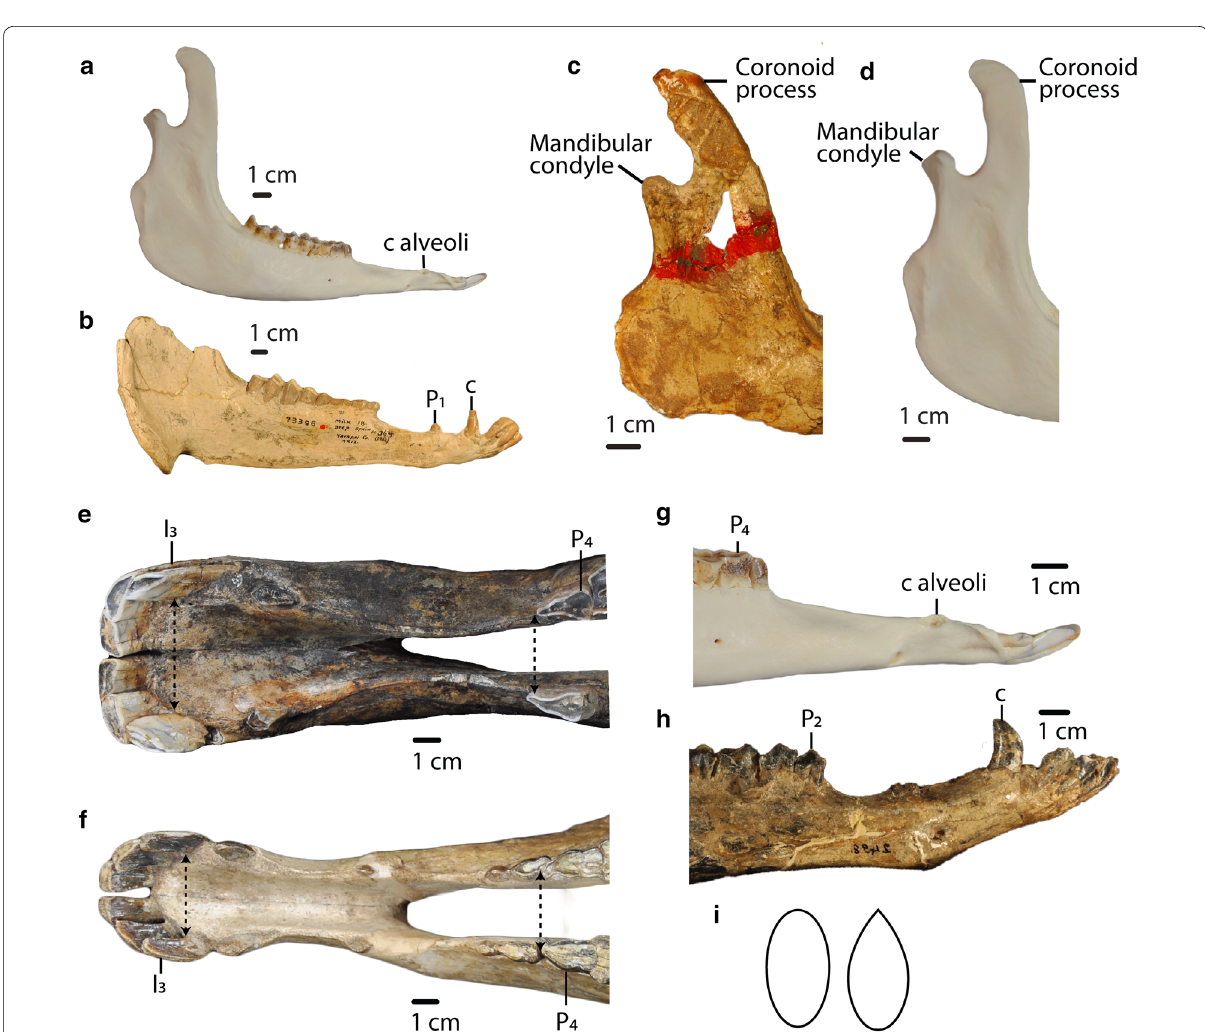
Fig. 9 a , b : Char. 42: “Angle of the mandible in lateral view”. a L. guanicoe (ZM 17,967), left side, scored rounded (2). b P. coartatus (AMNH 73,306), right side, scored ventrally produced with lateral flare (1). c , d : Char. 43: “ Coronoid process at the level of the mandibular condyle in lateral view”. c T. brachyodontus (AMNH 36,594), right side, scored angled posteriorly (0). d L. guanicoe (ZM 17,967), left side, scored straight (1). e , f : Char. 40: “Distance between mesial end of the third lower incisors compared to the distance between the mesial end of fourth lower premolars”. e C. minidokae (UCMP 38,448), scored distance between I 3 greater than distance between P 4 (1). f P. grandis (UCMP 32,864), scored distance between P 4 greater or equal to distance between I 3 (0). g , h : Char. 39: “Anterior part of the mandible in lateral view”. g L. guanicoe (ZM 17,967), left side, scored straight (0). h T. longirostris (CM 2498), left side, scored angled dorsally (1). i Char. 41: “Portion of the mandibular ramus below the mandibular diastema in transverse section”. Left: Little narrowing dorsally, ovoid (1). Right: Strongly narrowing dorsally, tear‑drop shaped